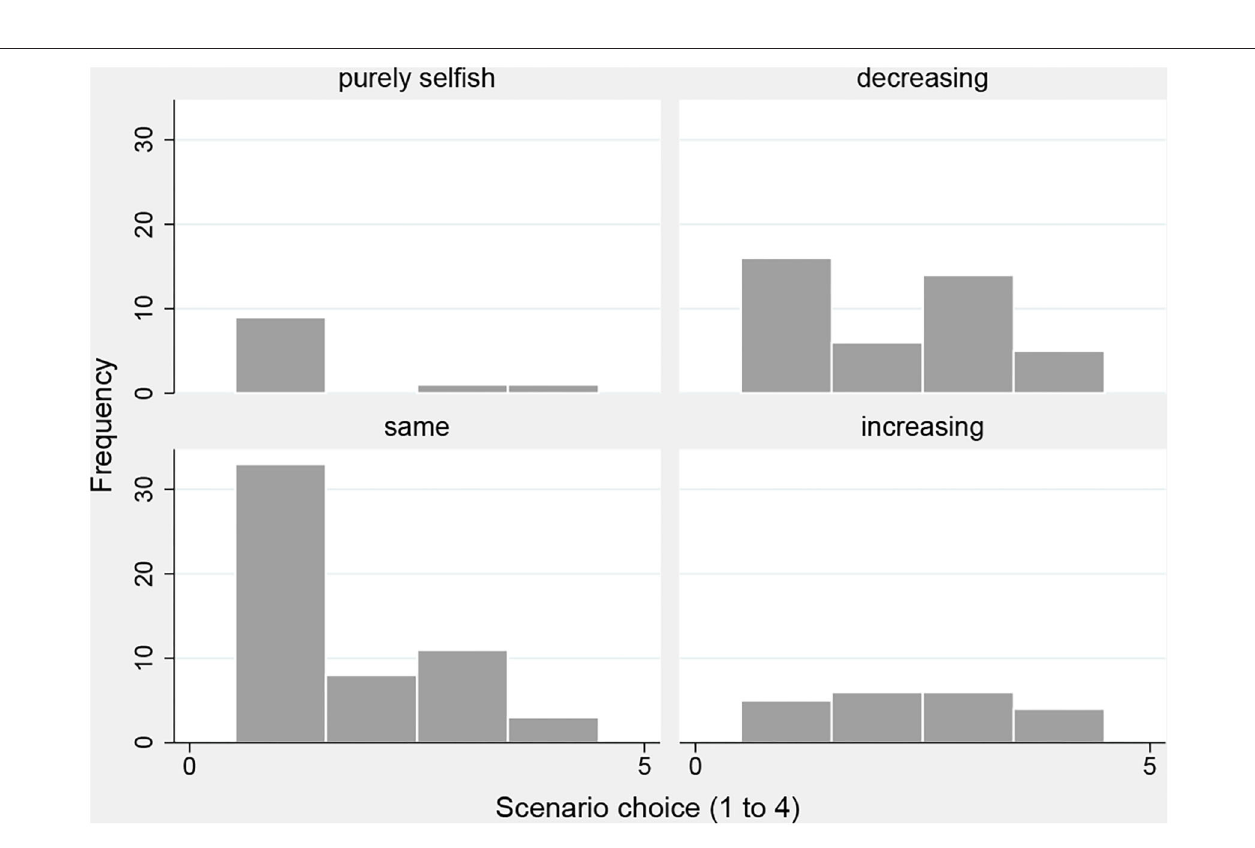
FIGURE 2 | Scenario choices by